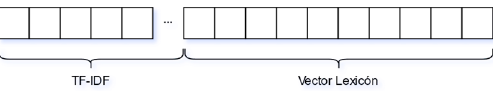
Figure 4. TF-IDF_Lexicon approach feature vector.